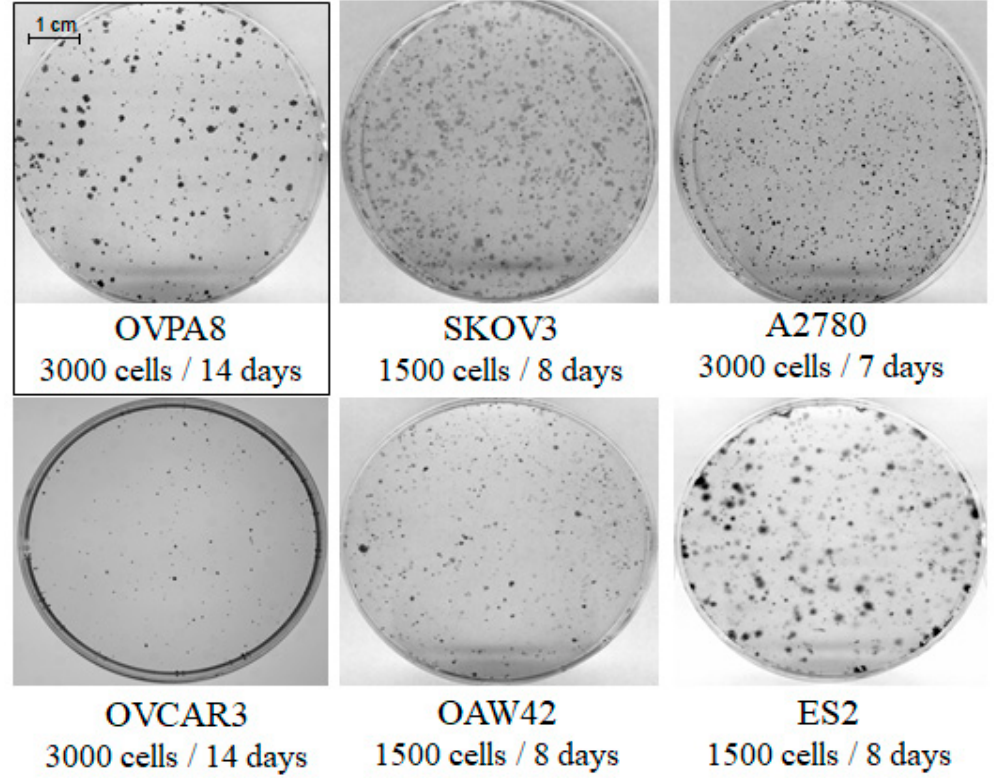
Figure 5. Clonogenic growth of OVPA8 and other ovarian cancer cells. Cells were seeded at the indicated densities and grown for 8–14 days. Afterwards, colonies were fixed, stained with crystal violet, and imaged. The picture shows representative digital images of colonies from one out of three technical replicates from 2–3 independent experiments.